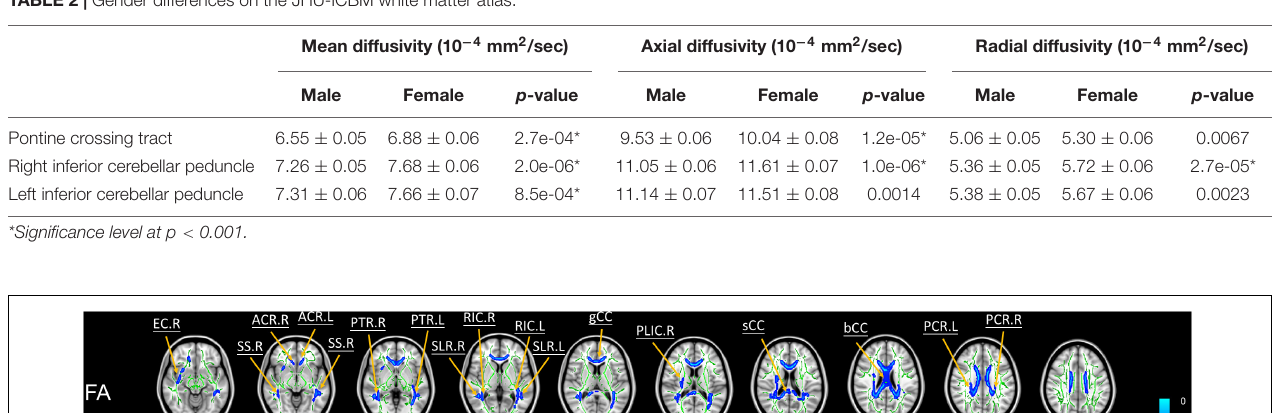
TABLE 2 | Gender differences on the JHU-ICBM white matter atlas.